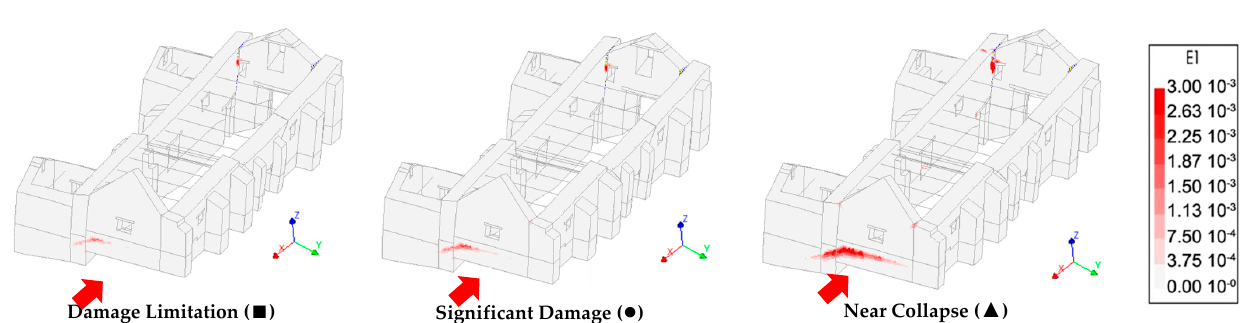
Figure 28. Damage Limitation (solid black line), Significant Damage (dotted black line) and Near Collapse (dash-dot black line) elastic demand spectra and bilinearized SDOF capacity diagrams indicating the target displacements ( ∎ , ● , ▲ ) in the − XX direction. The distribution of maximum principal plastic strains corresponding to the attainment of the target displacement at each performance level is shown in the contour diagrams. Table 9. Data used to obtain target displacement of MDOF system for different performance limit